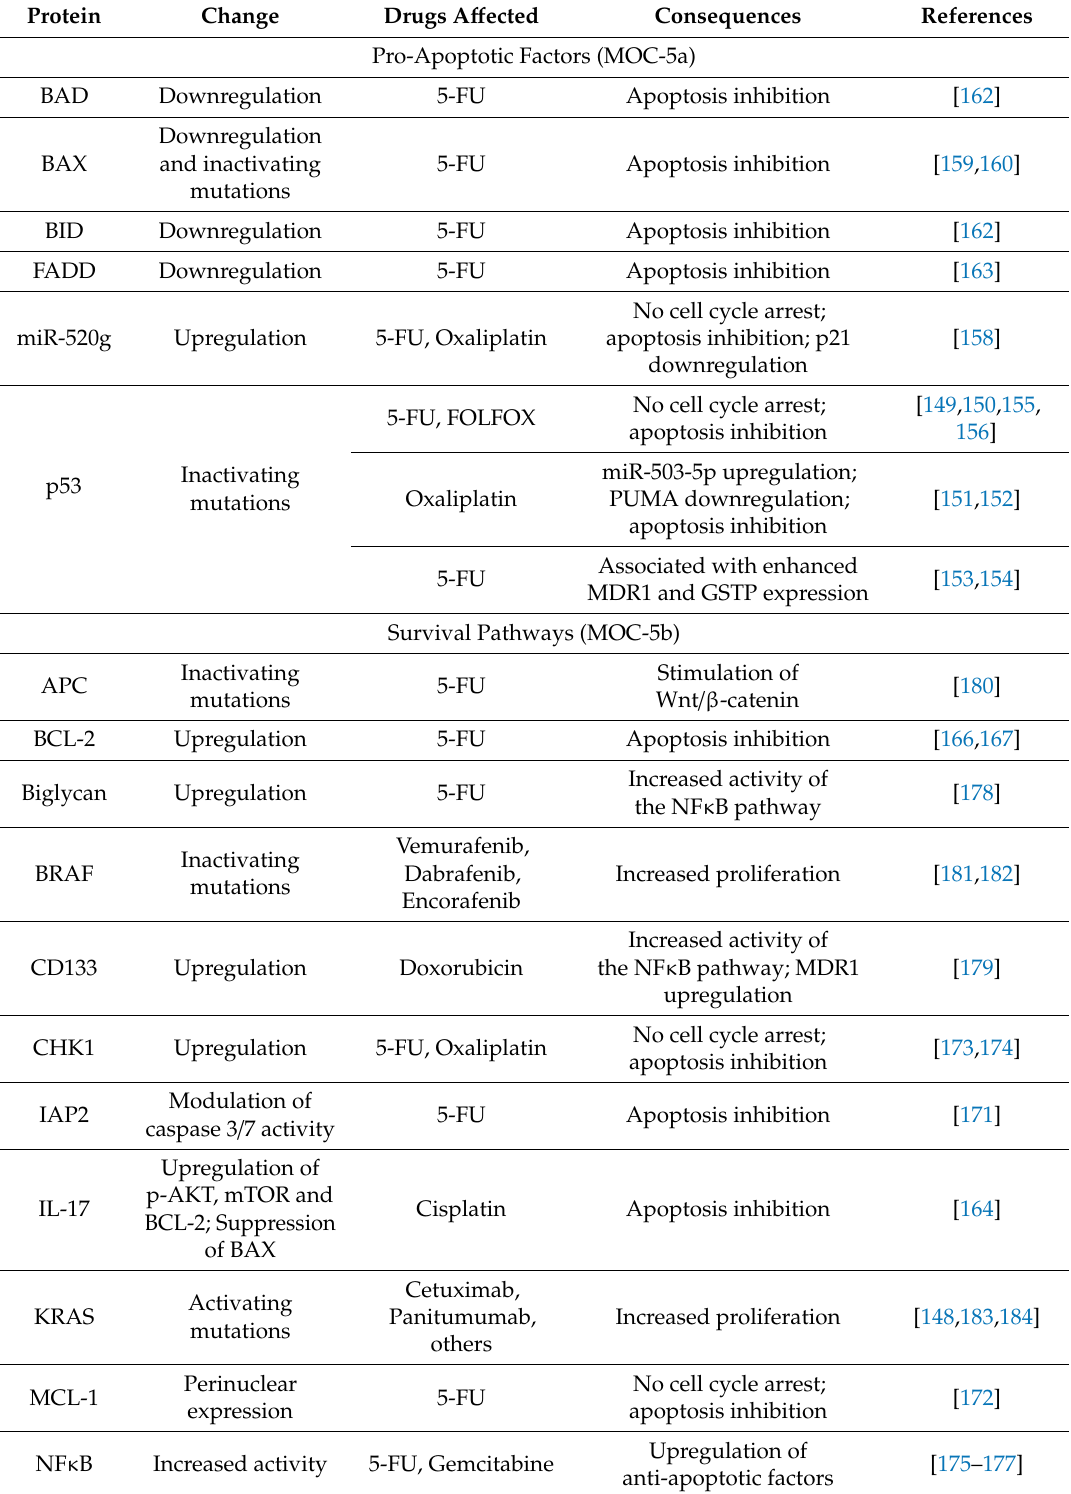
Table 5. Mechanisms of chemoresistance type 5 (MOC-5) in colorectal